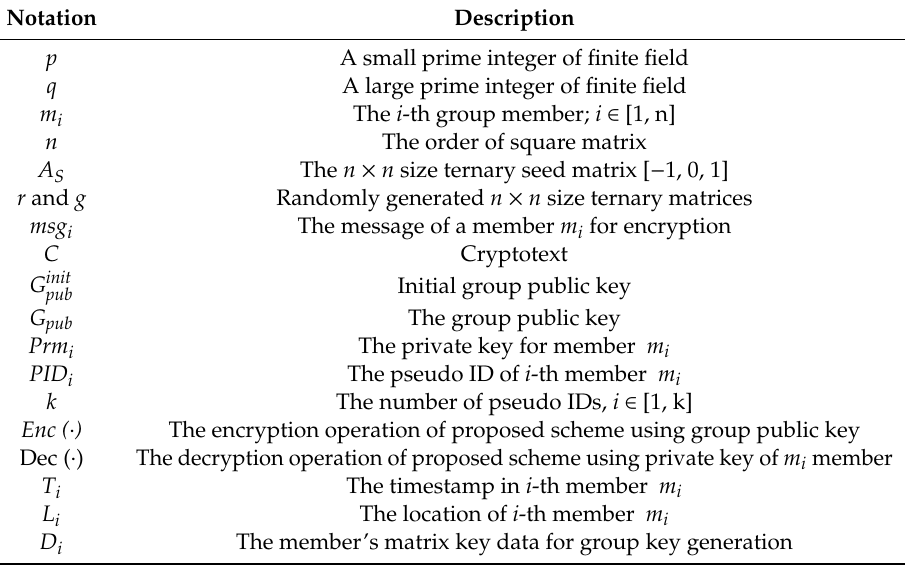
Table 1. Notations and descriptions.